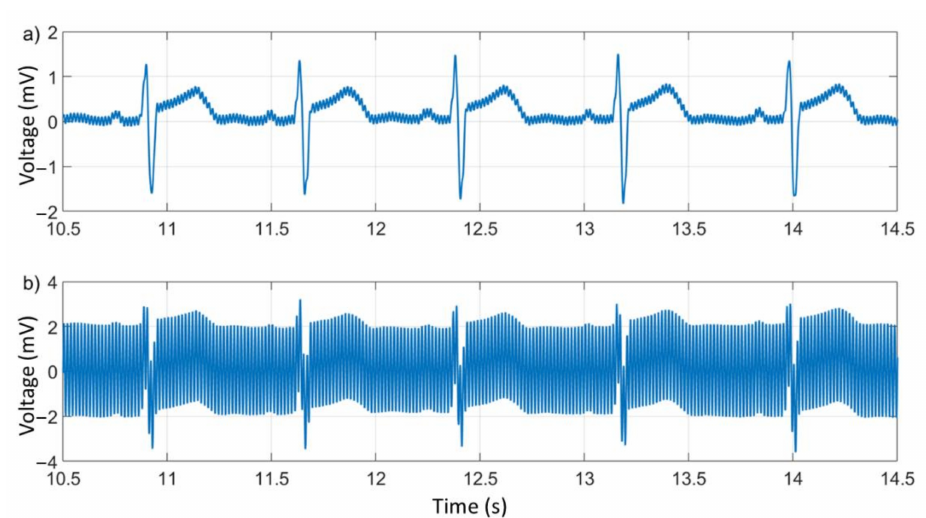
Figure 14. Original ECG signal.